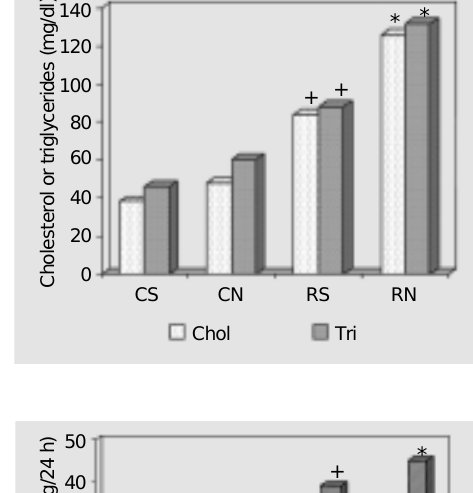
Figure 2. Effect of linoleic acid dietary supplement on proteinu- ria (PTN) 21, 41 and 61 days af- ter renal mass reduction. For group abbreviations see legend to Table 2. + P<0.05 compared to CS; *P<0.05 compared to CN (Duncan test).